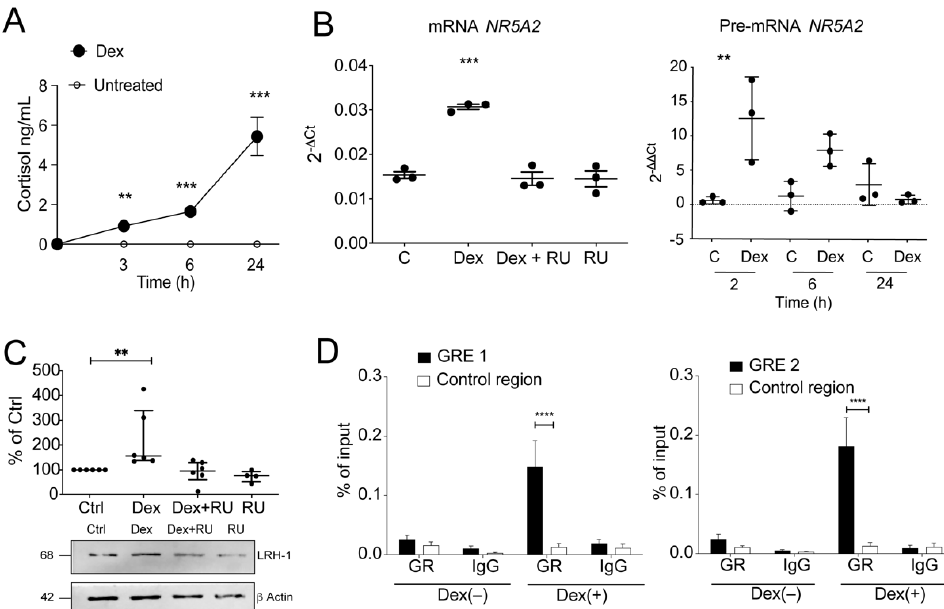
Figure 6. Dexamethasone induces cortisol and LRH-1, enhancing GR-binding to the NR5A2 gene promoter in colonocytes. ( A ) The CCD841CoN colonocyte cell line was stimulated with dexamethasone (100 nM) for 3, 6 and 24 h, and cortisol levels were determined in supernatants by ELISA; ( B ) Cells upon Dex and/or GR antagonist RU-486 (10 µM) treatment for 8 h were used to evaluate mature ( left ) and precursor ( right ) NR5A2 mRNA by RT-qPCR, and protein content by immunoblot; ( C ) Band quantification was performed by densitometry analysis and normalized to β -actin protein (% of control); ( D ) Cells stimulated with Dex for 2 h were analyzed for binding of GR to the NR5A2 promoter by ChIP-qPCR; For each immunoprecipitated sample, the statistical analyses were performed with respect to an unrelated region from the GAPDH gene promoter. Results are expressed as % input ± SEM. One-way ANOVA with Tukey post-test was performed. ** p < 0.01, *** p < 0.001, **** p < 0.0001. C: control, Dex: dexamethasone, RU: RU-486, GRE: glucocorticoid responsive element, IgG: immunoglobulin G, nt: nucleotides; n =